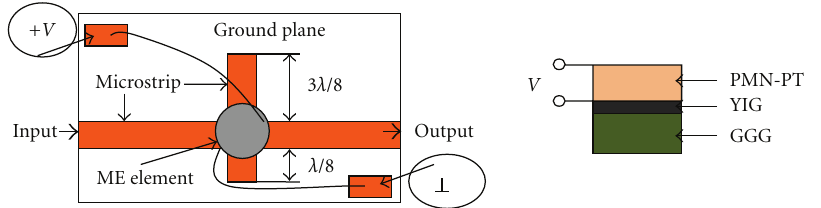
Figure 2: Design of microstrip ME attenuator and ME resonator.